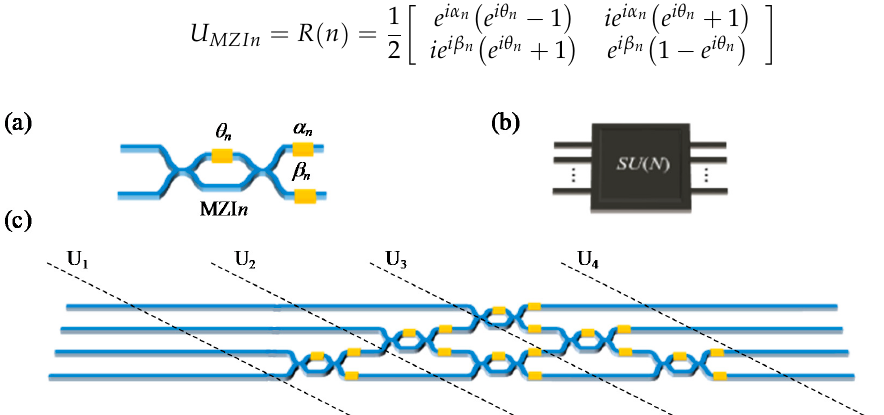
Figure 7. The principle of the MZI matrix core. ( a ) The structure of one MZI used in an MZI matrix core. ( b ) The whole MZI mesh consists of MZI matrix cores, and MZIs can be equivalent to a reconfigurable black box. ( c ) A typical example of a 4 × 4 network structure enabled by an MZI matrix